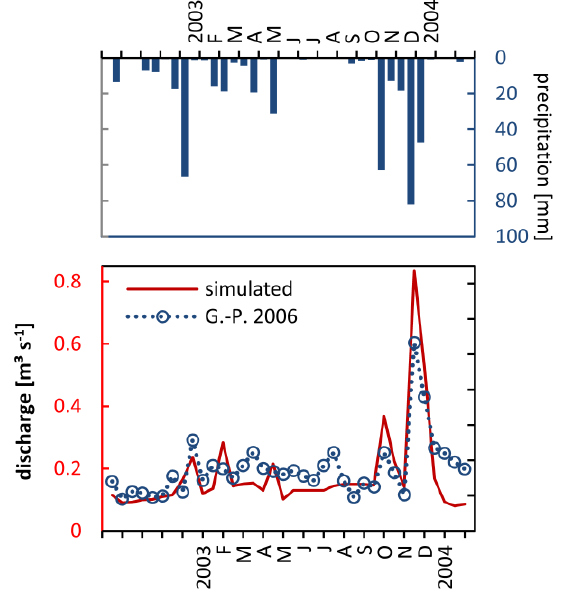
Figure 6. Comparison of simulated and estimated (Garcia-Pintado et al. [18]) biweekly discharge for the Albujon wadi catchment (including the diversion from Rambla de la